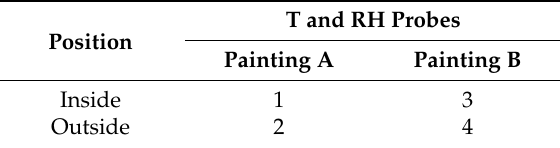
Table 1. Position of temperature (T) and relative humidity (RH) probes in the monitoring campaign. T and RH Probes Position Painting A Inside Outside 2